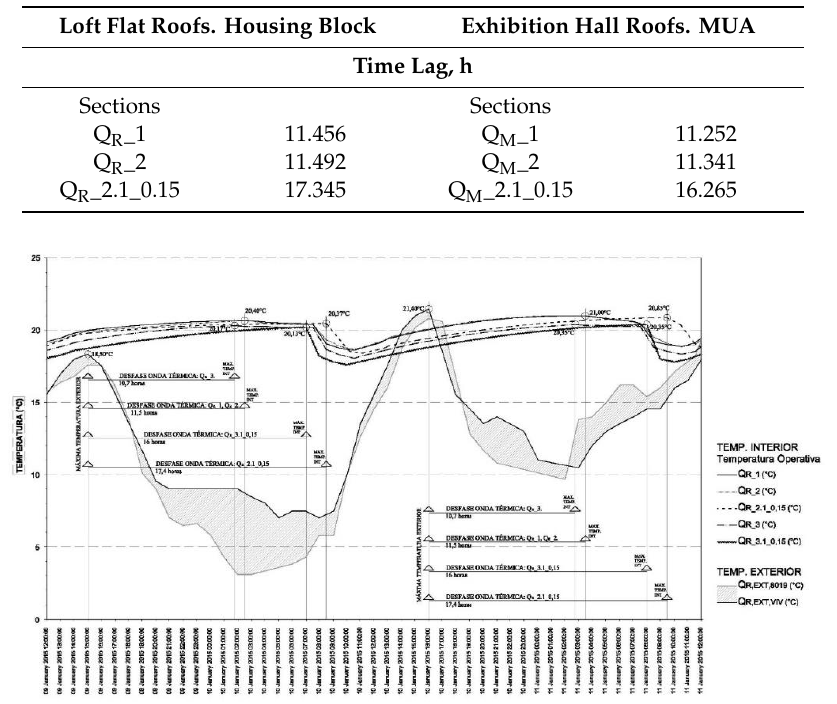
Figure 9. Relationship between outside and indoor ambient temperatures, time lag and decrement factor of the different roof types for the flat.